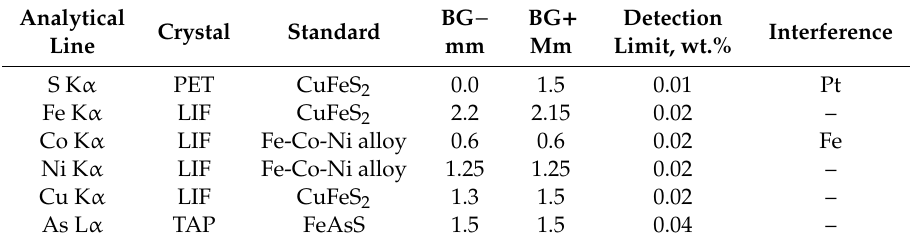
Table 1. Analytical conditions for determining the composition of